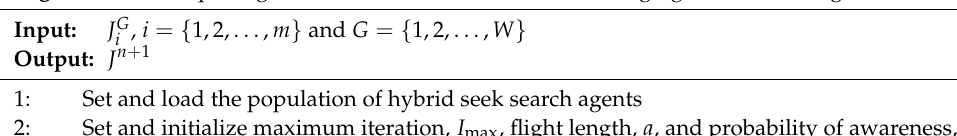
Algorithm 1: Comprising the features of corvid search and the gregarious search